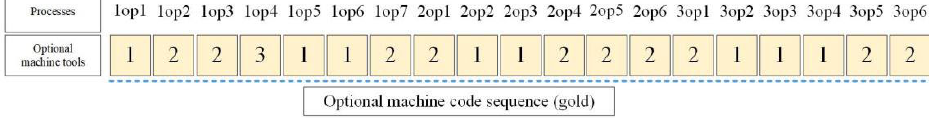
Figure 5. Tool layer encoding sequence. Therefore, each bee chromosome should contain the four sequences shown in Figure 6: